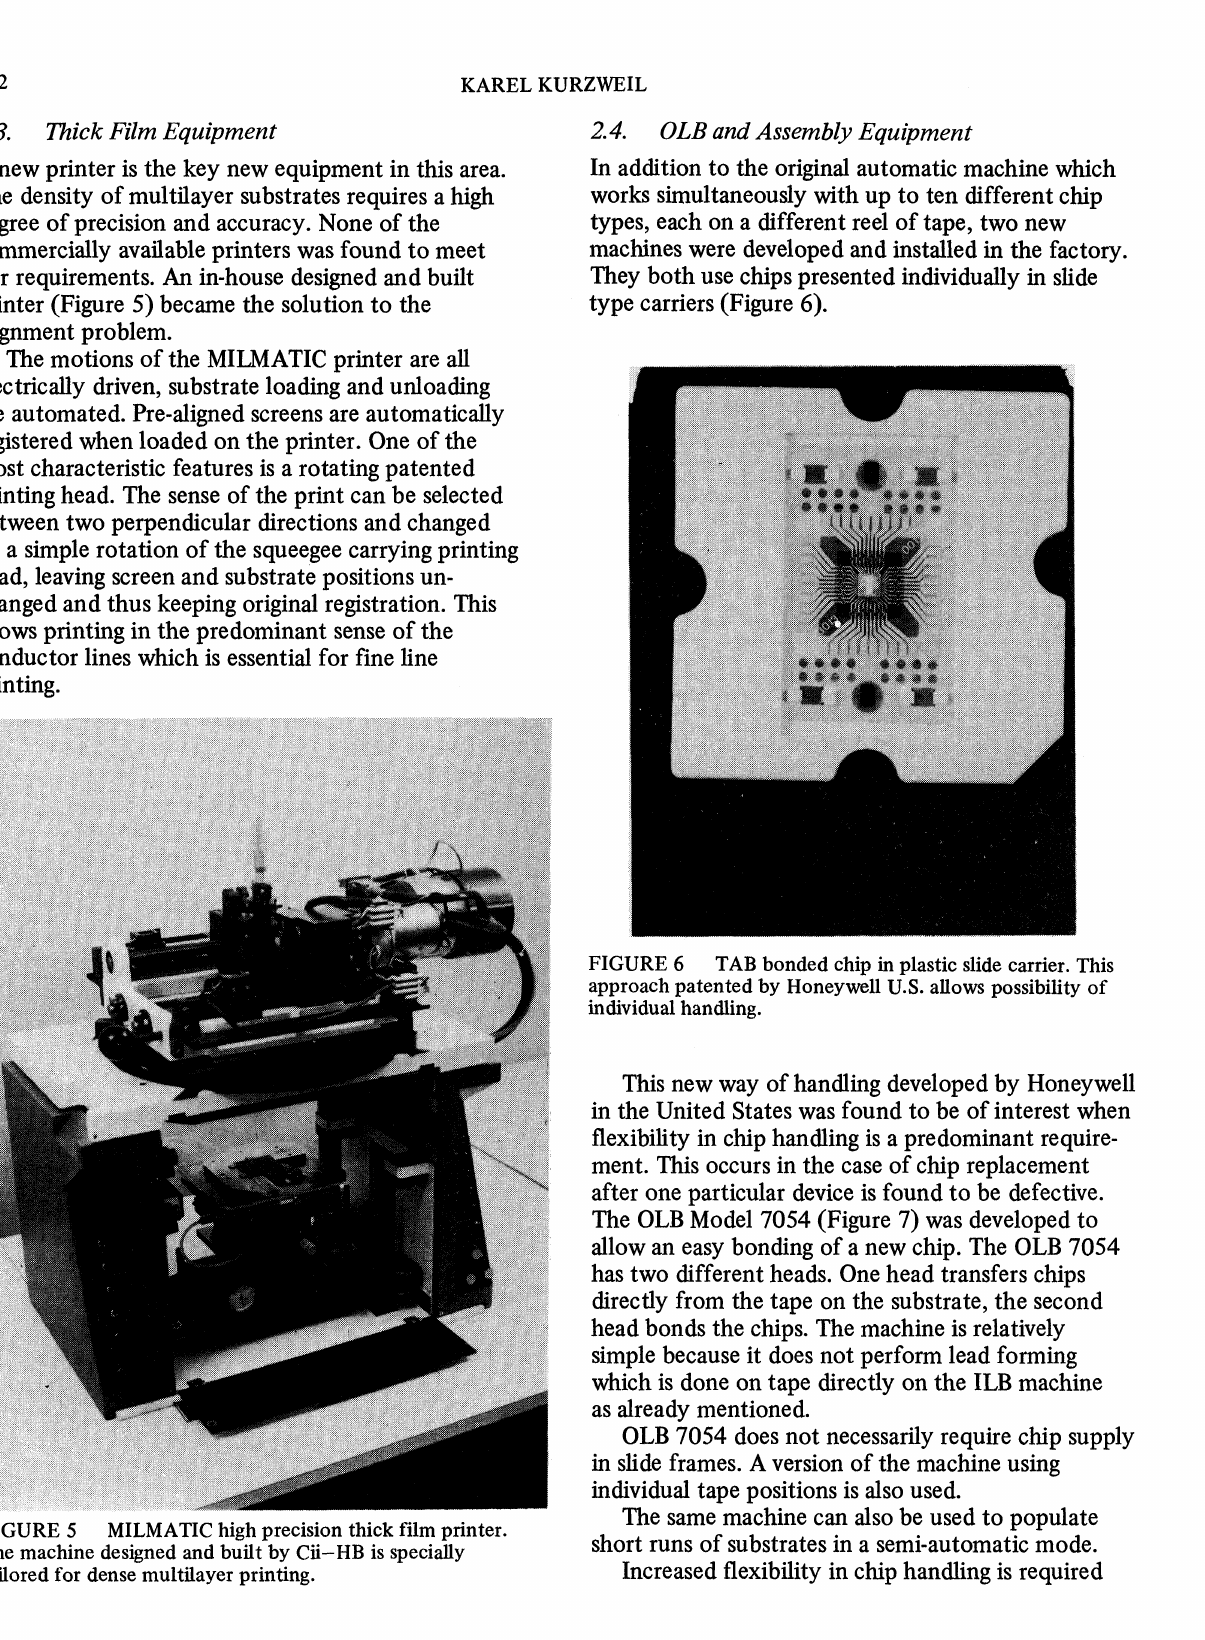
MILMATIC high precision thick film printer. The machine designed and built by Cii-HB is specially tailored for dense multilayer